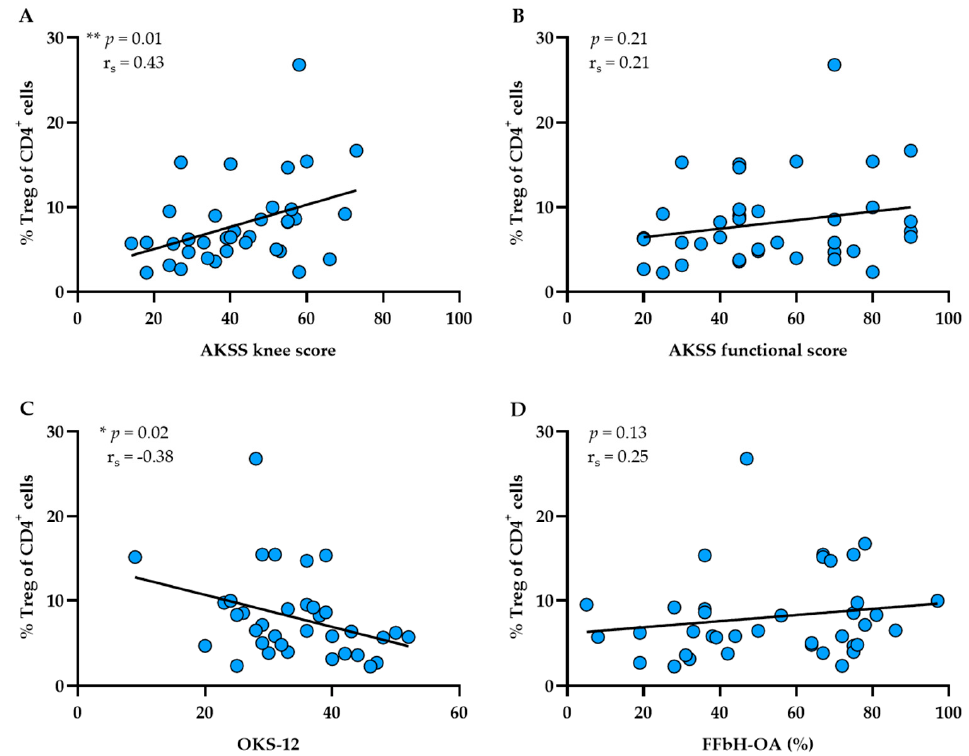
Figure 4. Correlation analyses between synovial membrane (SM) infiltration of Tregs and functional parameters of knee OA patients. Spearman’s rank correlation coefficient (r s ) revealed that Treg proportions (% Treg) significantly correlated with knee joint function. Higher percentage rates of Tregs in SM were associated with better scores in the ( A ) AKKS knee and ( C ) OKS-12. No significant associations were found between Treg proportions and AKSS functional ( B ) and FFbH-OA scores ( D ). p -Values < 0.05 were considered statistically significant and are indicated with asterisks: * p < 0.05, ** p < 0.01. AKSS = American Knee Society Score; FFbH-OA = Hannover Functional Questionnaire of Functional Disability Caused by OA; OKS-12 = Oxford Knee Score.